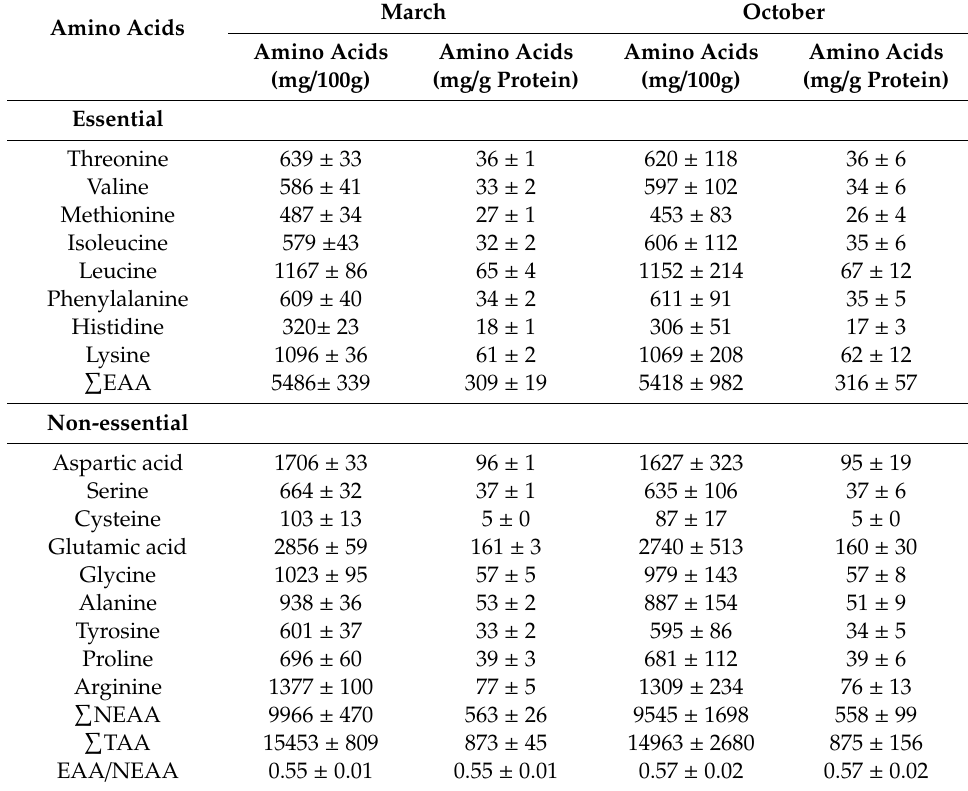
Table 4. Amino acid profile (in mg / 100 g wet weight and mg / g protein) of the muscle proteins of C. maritae caught in March and October (average ± standard